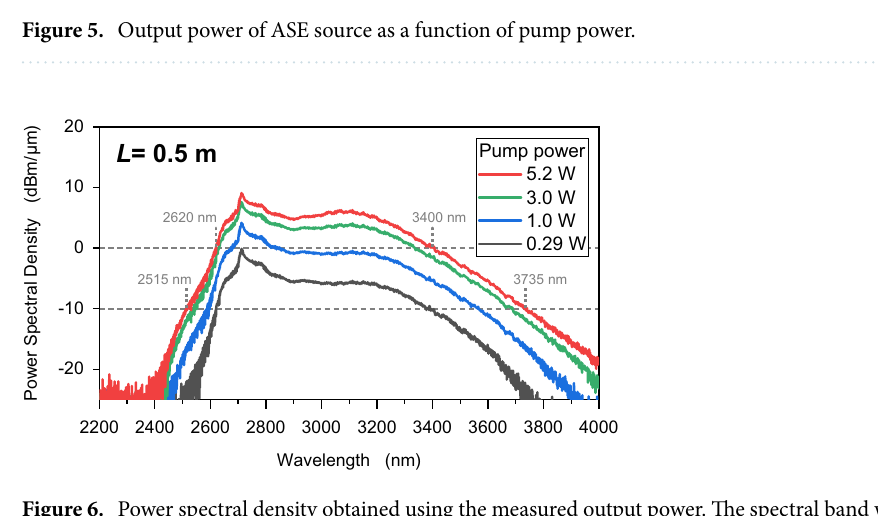
Figure 6. Power spectral density obtained using the measured output power. The spectral band width was measured at power spectral densities of 0 and − 10